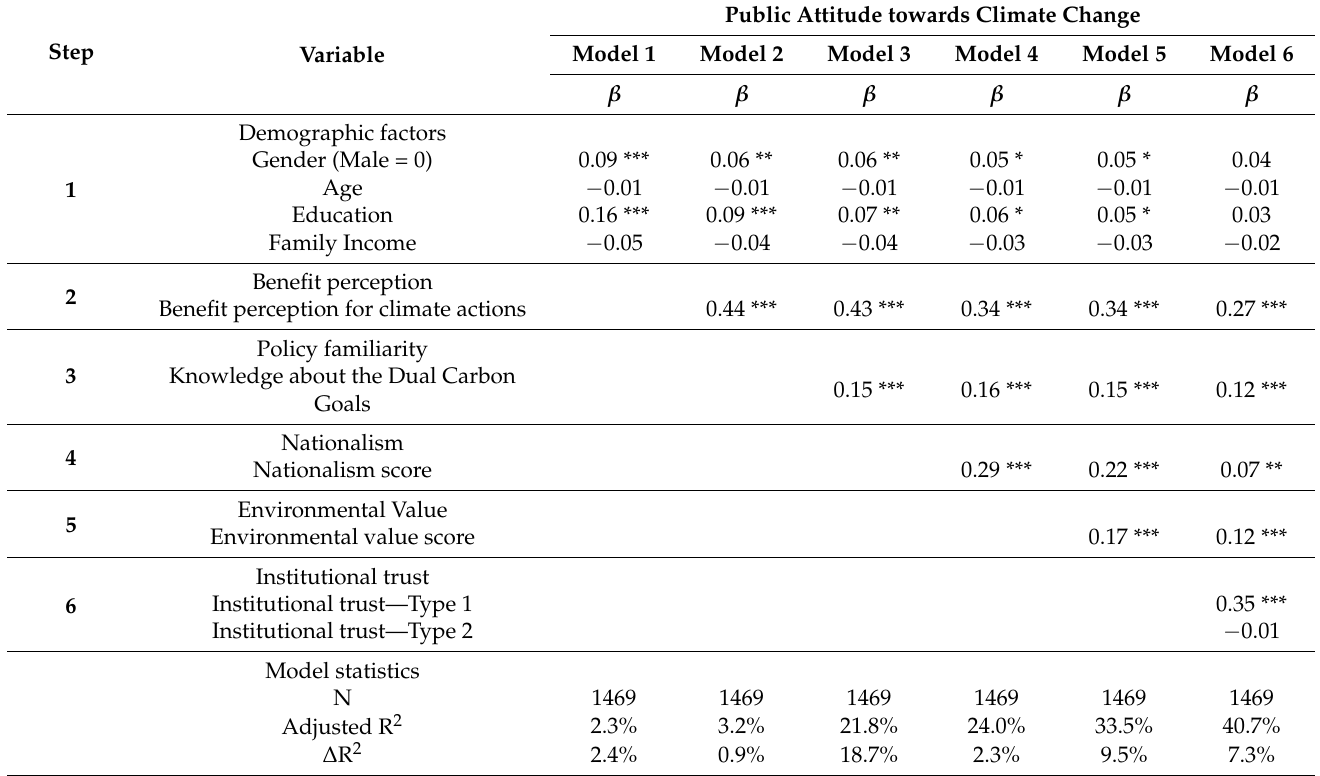
Table 8. Hierarchical regression model of factors associated with attitudes towards climate change ( n =